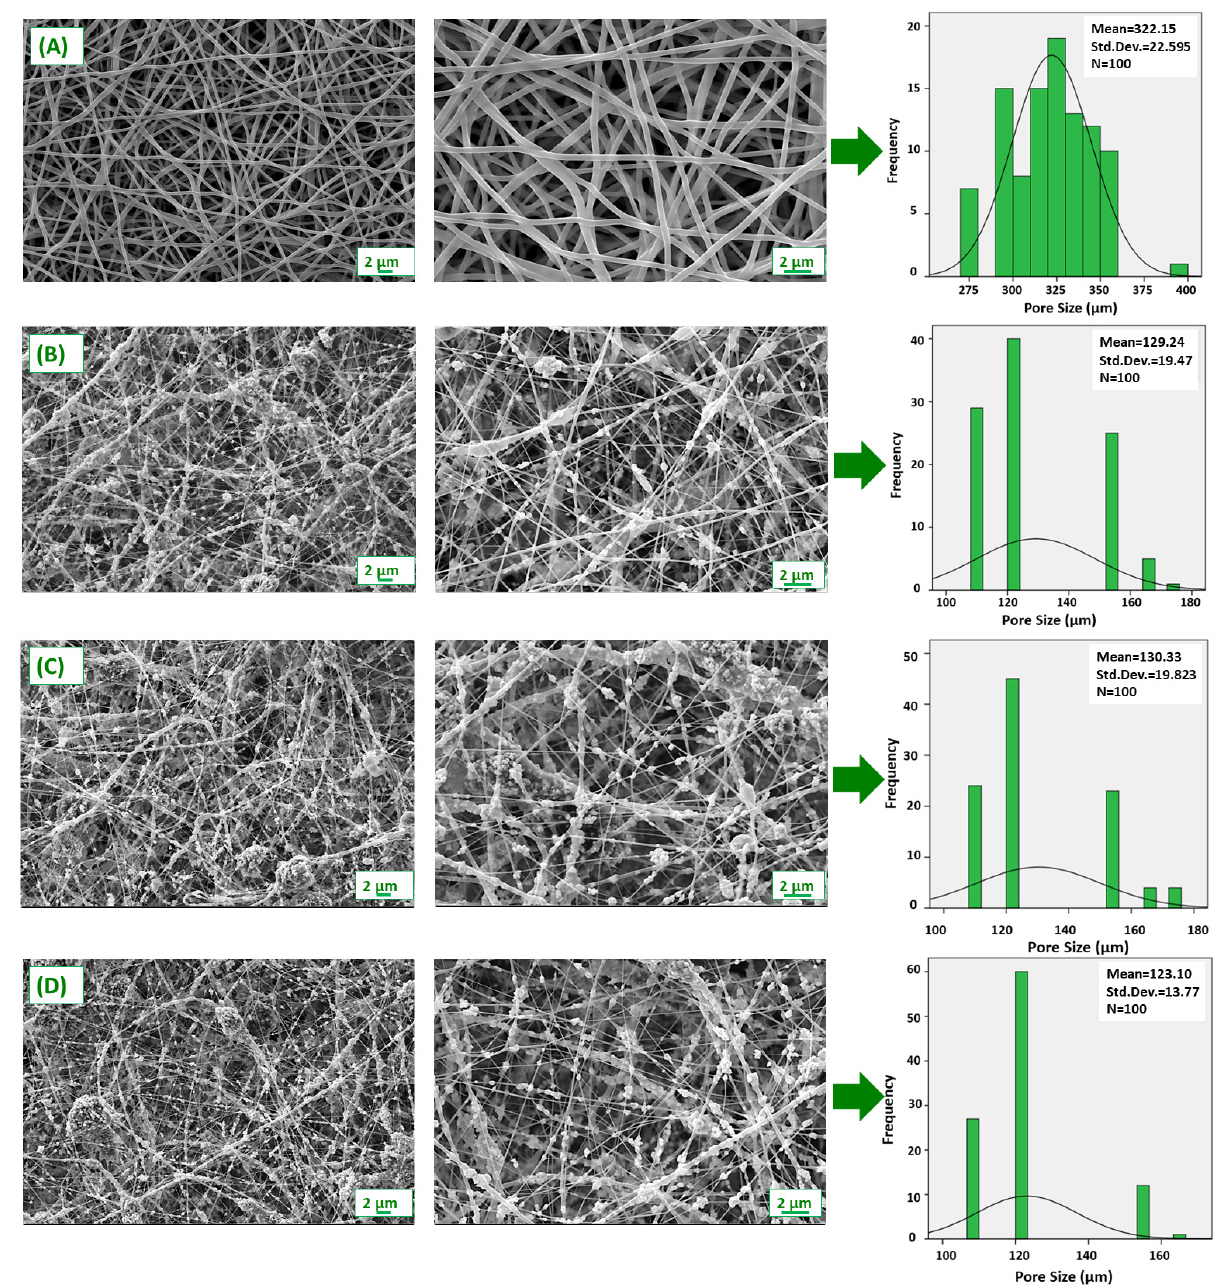
Figure 3. SEM images and pore size histogram of ( A ) pure PVA, ( B ) PVA/%20 ZnO, ( C ) PVA/%40 ZnO, and ( D ) PVA/%60 ZnO